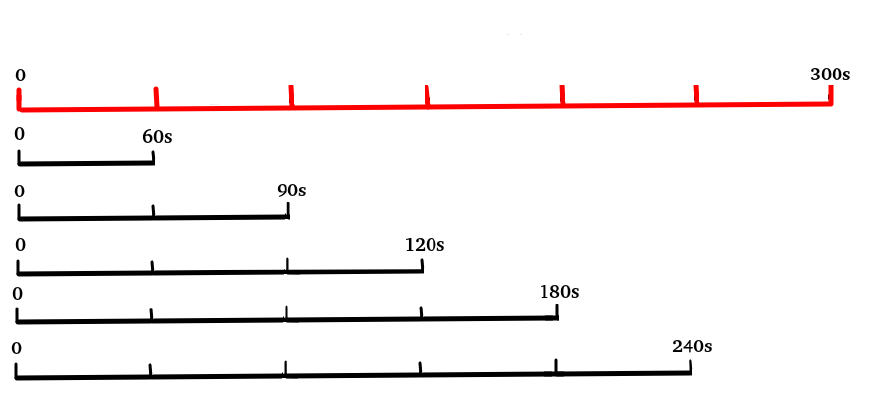
Figure 4: RR series graphic representation with different time lengths in seconds starting from the beginning. The series of 300s corresponds to the Gold